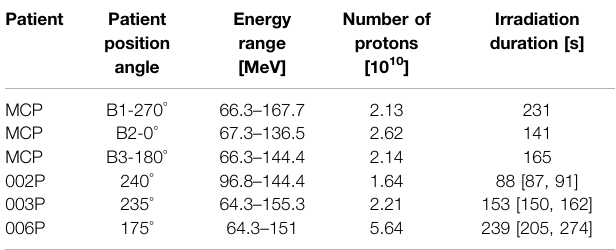
TABLE1| Treatment fi eldparametersandirradiationdurationtimesforeachofthe considered cases. Patient Patient